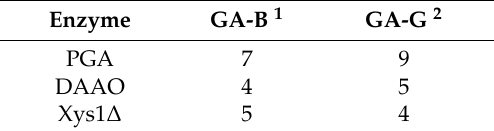
Table 2. Quantification of lysine residues attached to the support.